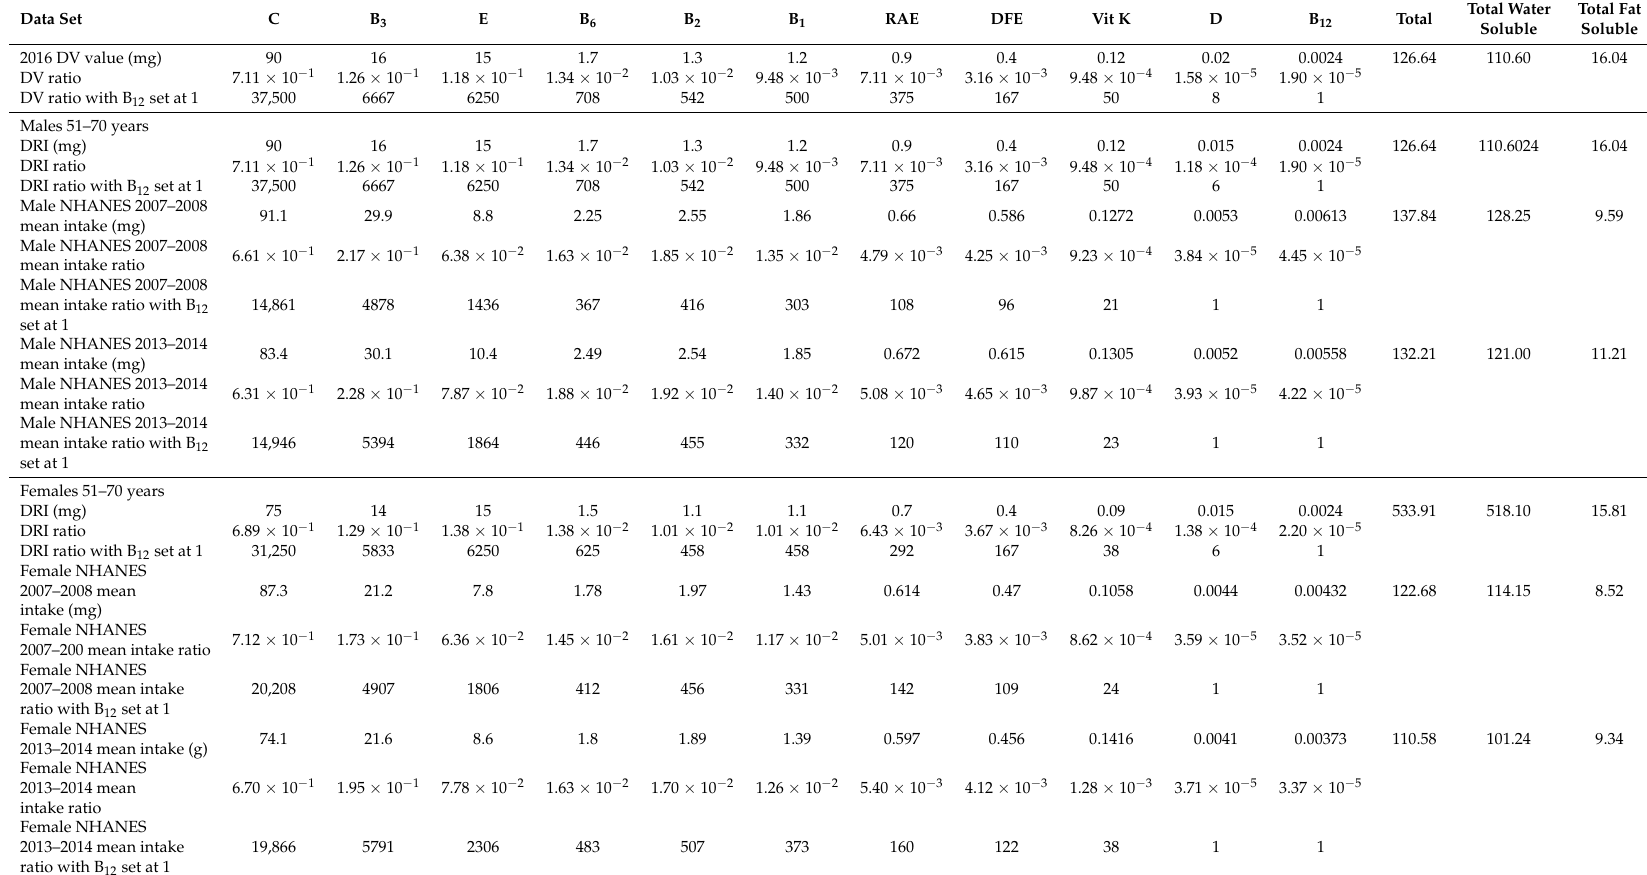
Values are rounded. Abbreviations: vitamin A (as retinol activity equivalents (RAE)), thiamin (B 1 ), riboflavin (B 2 ), niacin (B 3 ), pyridoxine (B 6 ), cobalamin (B 12 ), folate (as dietary folate equivalent (DFE)), vitamin C (C), vitamin D (D), vitamin E (E) and vitamin K (Vit